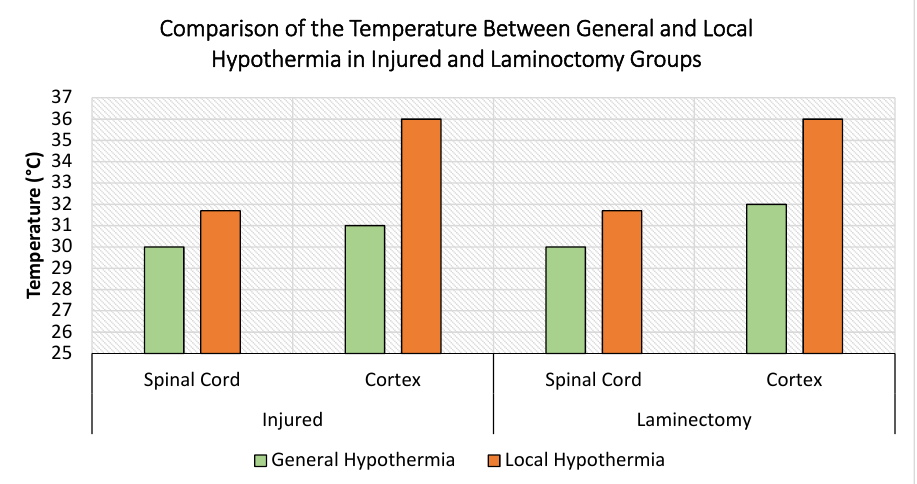
Figure 2. Shows the temperature profiles of rats’ cortex and spinal cord parenchyma after induction of general (32 ± 0.5 °C) and local (30 ± 0.5 °C) hypothermia in (iright section) laminectomy (control without SCI) and (left section) the injury (moderate contusive SCI) groups. During the local hypothermia, the core temperature was successfully maintained at 37.3 °C ± 0.7 °C. We investigated the neuroprotective effect of 2 h general hypothermia at 32 °C ± 0.5 °C as well as 5 h and 8 h prolonged local T7–T9 hypothermia at 30 °C ± 0.5 °C using the contusive moderate (12.5 mm) T8 thoracic SCI. To reflect the real-life situations, inducing hypothermia was delayed for 2 h post-SCI induction. The SSEP results show that the neuroelectrophysiology (SSEPs) improvements of 2 h general, as well as 5 h and 8 h local hypothermia are statistically significant. This, in turn,